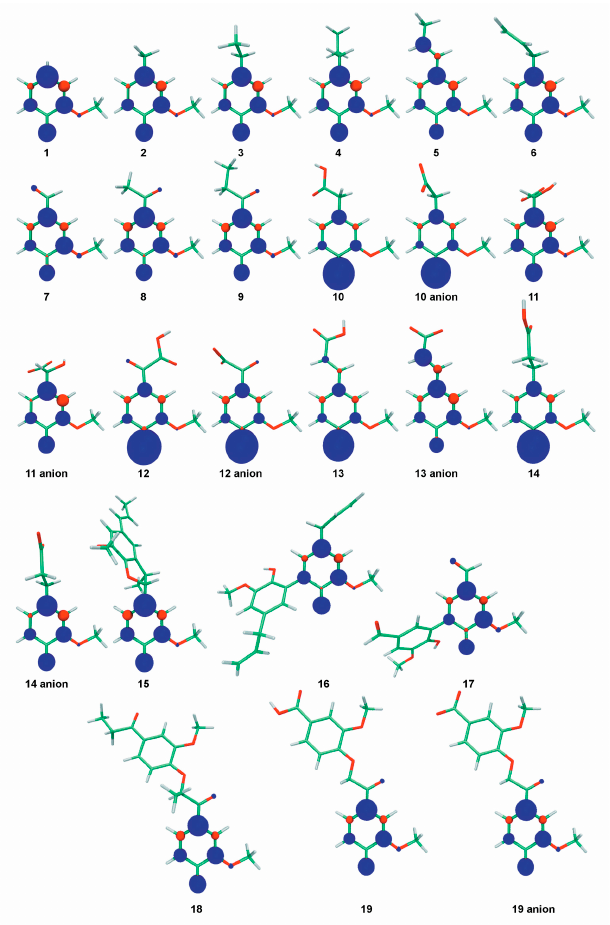
Figure 3. The spin density distribution of the aryloxyl radicals formed from the OH groups of the lignin-modeling structures.